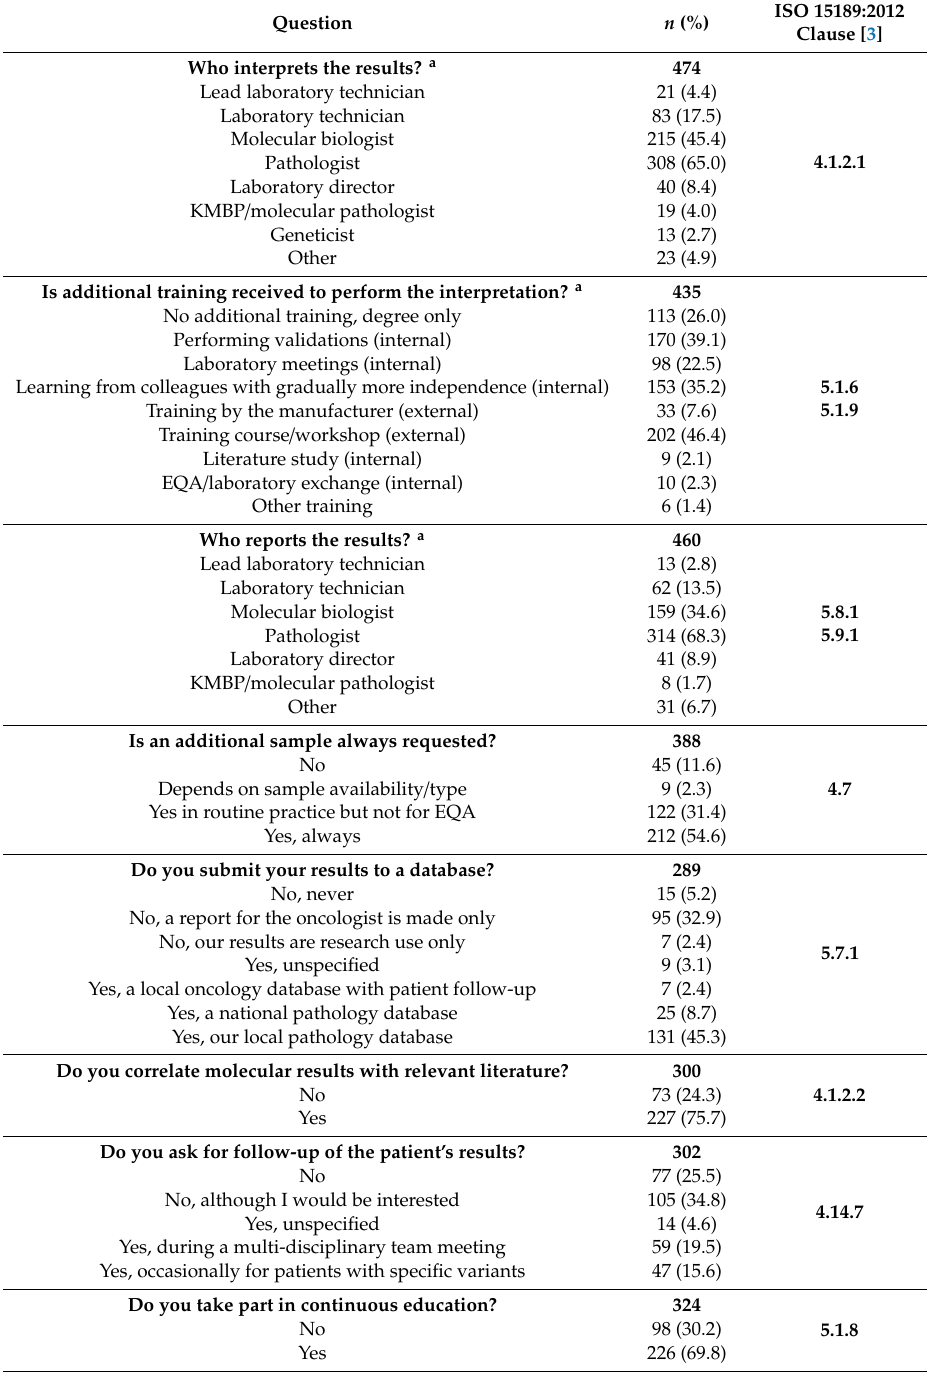
Table 3. Laboratories’ practices for handling of test results in a routine setting, irrespective of errors in the EQA